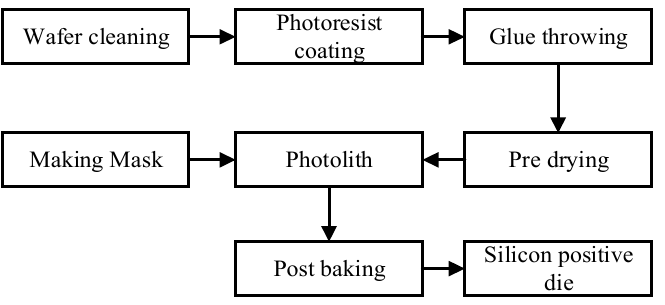
Figure 9. Processing of the silicon wafer positive die.